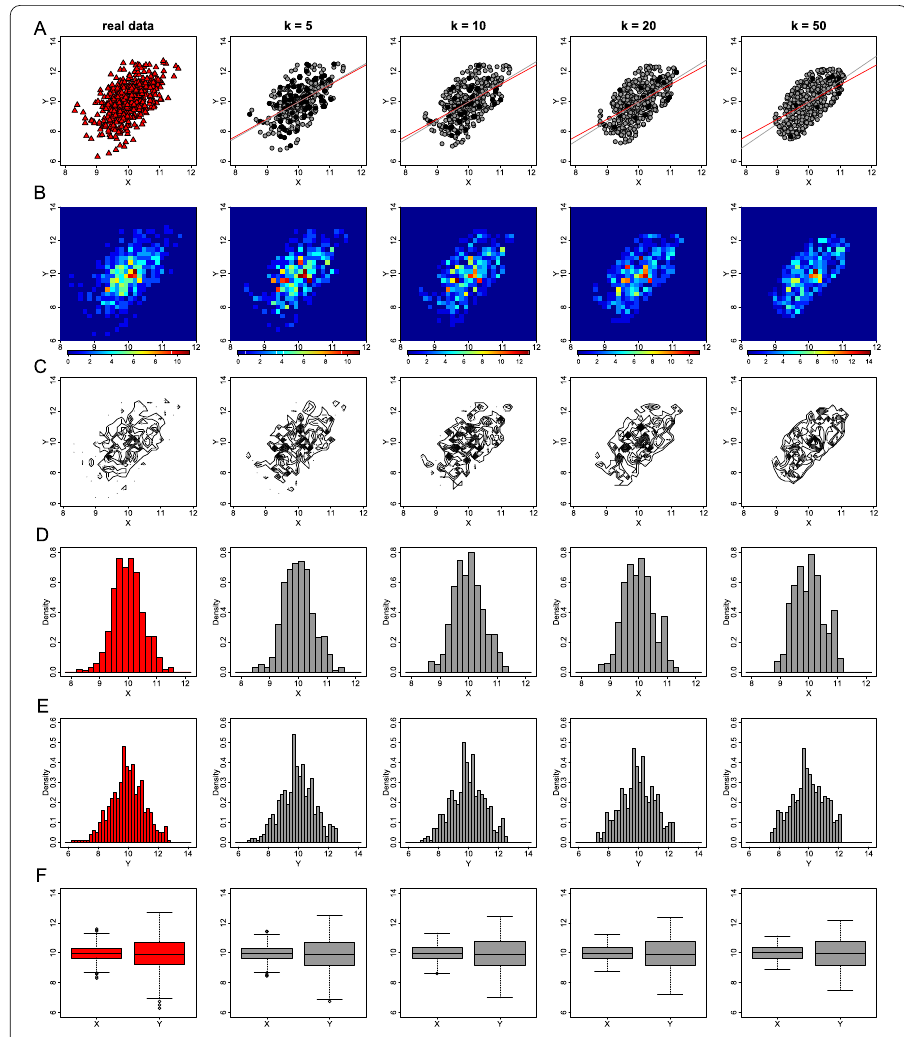
Figure 12 The effect of parameter k of the deterministic anonymization method on exploratory data visualizations. From left to right we demonstrate the effect of k for the values of 1 (this is equivalent to the real data), 5, 10, 20 and 50 on generating privacy-preserving scatter plots ( A ), heat map plots ( B ), contour plots ( C ), histograms of X ( D ) and Y ( E ), and box plots ( F )